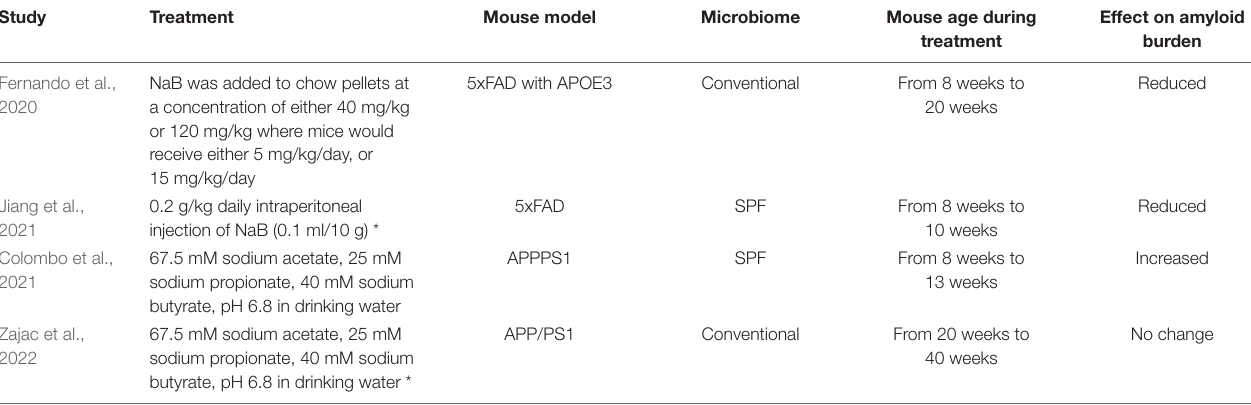
TABLE 3 | Comparison of studies evaluating short chain fatty acids (SCFA) effects on murine amyloid